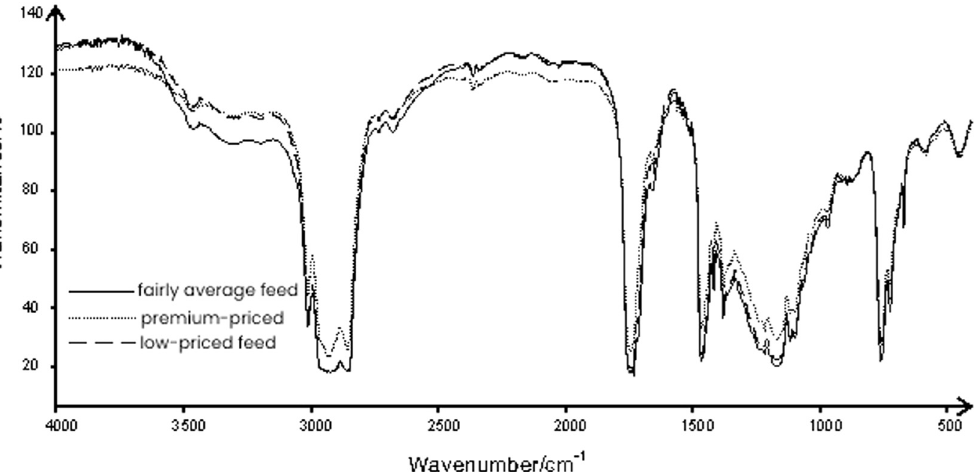
Figure 2: IR spectra registered for low - priced, fairly average priced and premium - priced cat feeds as a radiation transmittance against wavenumber in the range 4,000 – 400 cm − 1 .